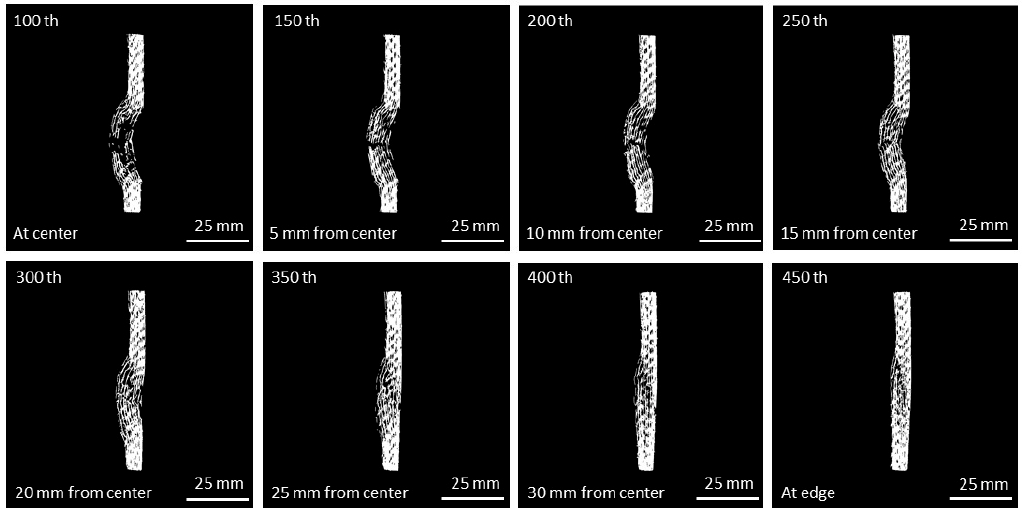
Figure 4. Carbon fiber composite after impact. µ CT slices of damage from the center towards the edge. The fiber damage was investigated at the center and from each set of pictures, one picture was chosen at a distance of 5 mm towards the edge of the composite.